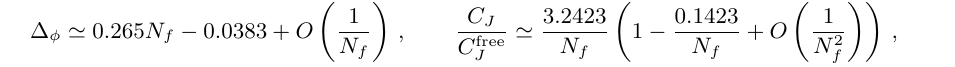
Figure 10 . Lower bound on the central charge C T /C 0 . 5192 , 0 . 605 , 1 . 05 . The shaded region is allowed. The bounds have been obtained at Λ = 13 . correlator and in the mixed channel,